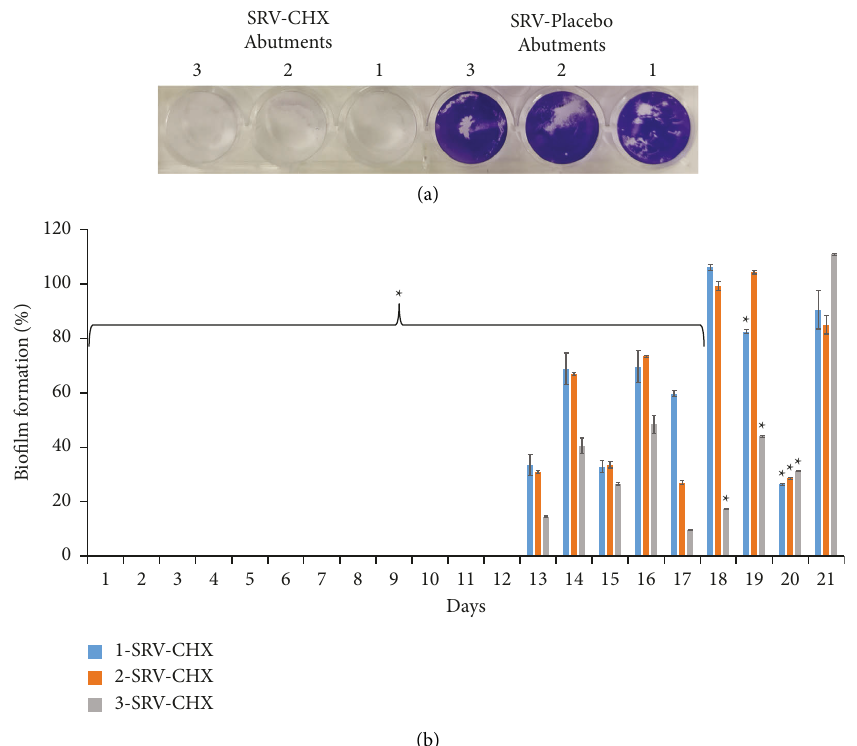
Figure 5: Biofilm formation around SRV-CHX-coated abutments. (a) Biofilm formation after 12 days of abutment passages. SRV-placebo and SRV-CHX-coated abutments 1, 2, and 3; (b) quantitative analysis of biofilm formation around SRV-CHX-coated abutments. The data are presented as a percentage and compared to the SRV-placebo (100%). ∗ Significantly lower than the value for SRV-placebo ( P < 0 . 05).